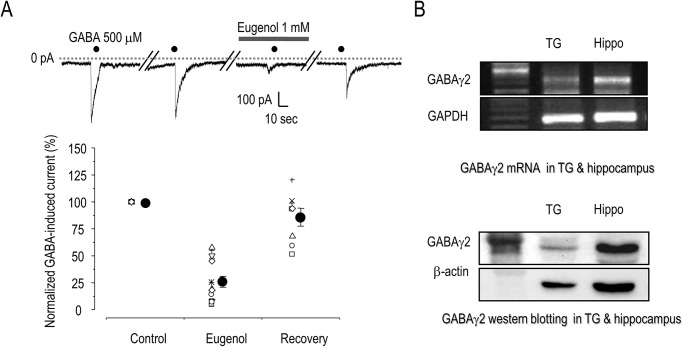
The effect of eugenol on GABA-induced currents in trigeminal ganglion neurons.(A) Eugenol (1 mM) abolished the GABA (500 μM)-induced current in TG neurons; the current recovered to the control value after washout of eugenol (*p < 0.05). (B) The γ2 subunit of the GABAA receptor was expressed in TG neurons. Data are expressed as mean ± SEM.